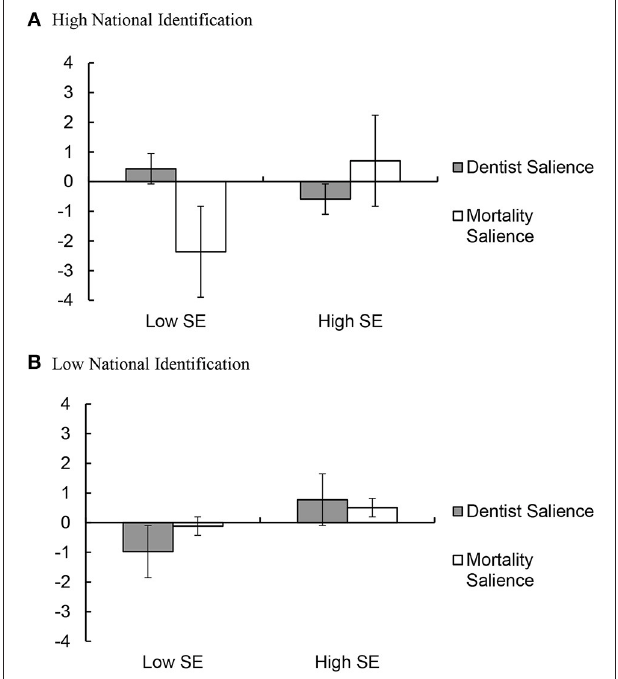
FIGURE 1 | Attitudes toward Muslims and multiculturalism in Dutch society as a function of mortality salience and self-esteem among participants (A) high vs. (B) low on identification. Higher numbers indicate more positive attitudes. Low and high levels of national identification, mortality salience and self-esteem were coded as 1 SD below and above the mean, respectively. The overall score was calculated by taking the average standardized scores across five worldview defense measures. Standard errors are shown as error bars attached to each